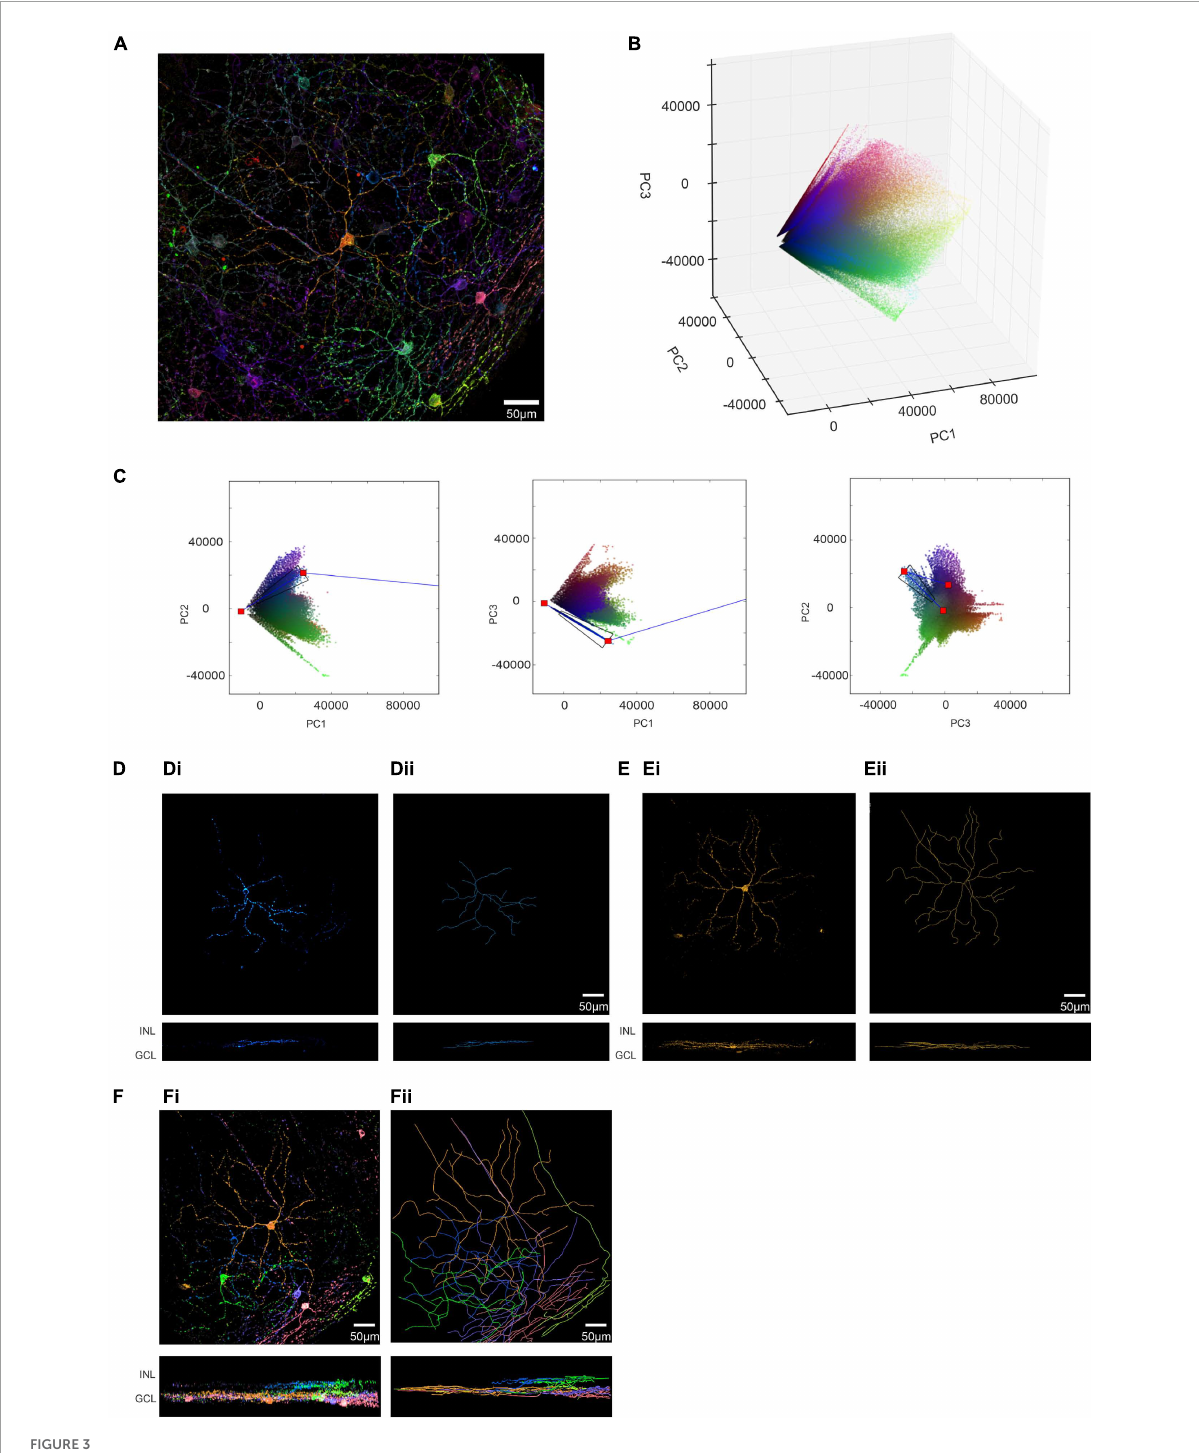
FIGURE3 Development of BRIAN and PCA for single cell isolation and 3D spatial reconstruction in the Opn4 Cre / + retina. (A) Pseudocolored immunofluorescence image of the ROI in Figure 1C following image pre-filtering to reduce background noise and remove voxels with signal in only one channel (see Online Methods). (B) 3D representation of PC space (PC1 vs. PC2 vs. PC3) of the ROI from the Opn4 Cre / + retina following image pre-filtering. (C) Following pre-filtering of the ROI an identifiable “blue” cluster of voxels became apparent in PCA space, shown here in sequential 2D projections in PC space of randomly selected 80,000 voxels (a number which we found to give a good visual approximation of the clusters at reduced rendering time). Blue lines depict the center of the vector directions of this cluster in each 2D plot from black and white points; red dots show origins (black and white points) and intersection of these vectors. A user defined trapezoid encompassing the voxels in this cluster is shown in black. (D) Spatial location of voxels in XY (upper) and XZ (lower) orientations of voxels from the ROI